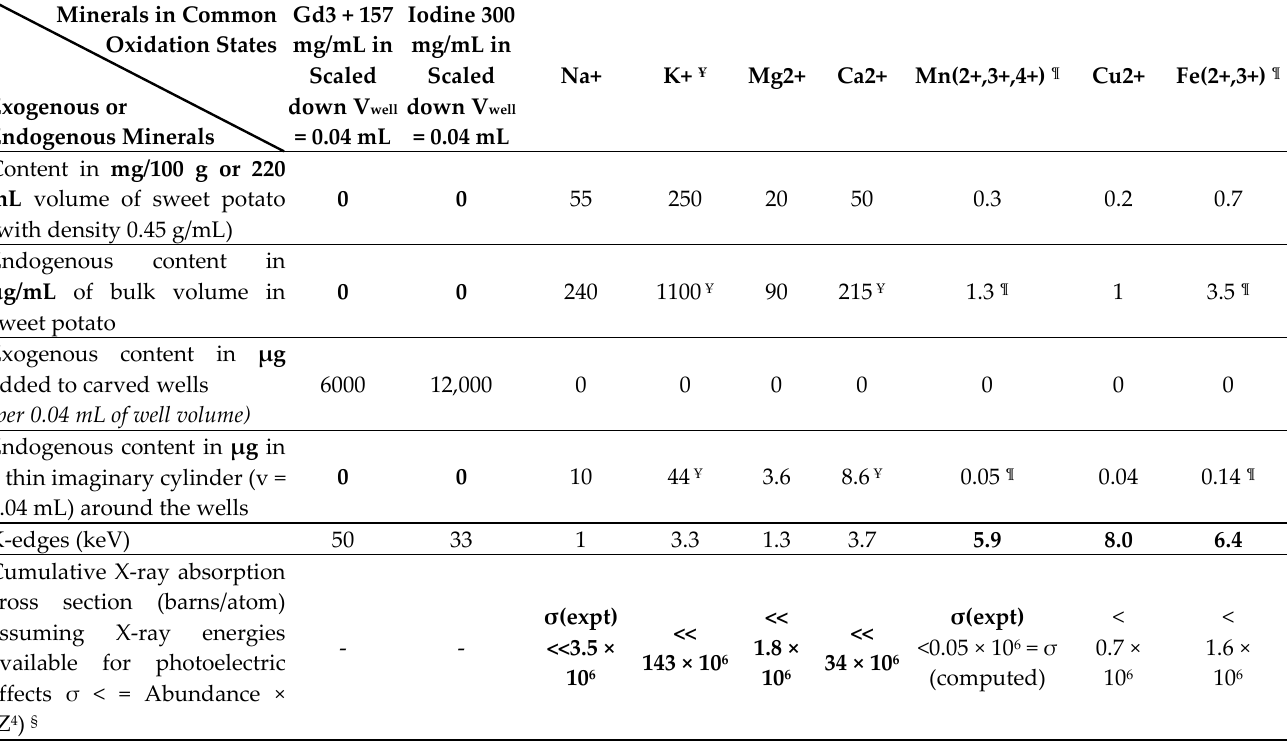
Table 2. Endogenous mineral content in sweet potato and the estimated amount available for transmetallation or chelation in a thin imaginary cylinder around the wells (scaled down the imaginary computation volume for sweet potato to match the volume used for apple in Table 1).